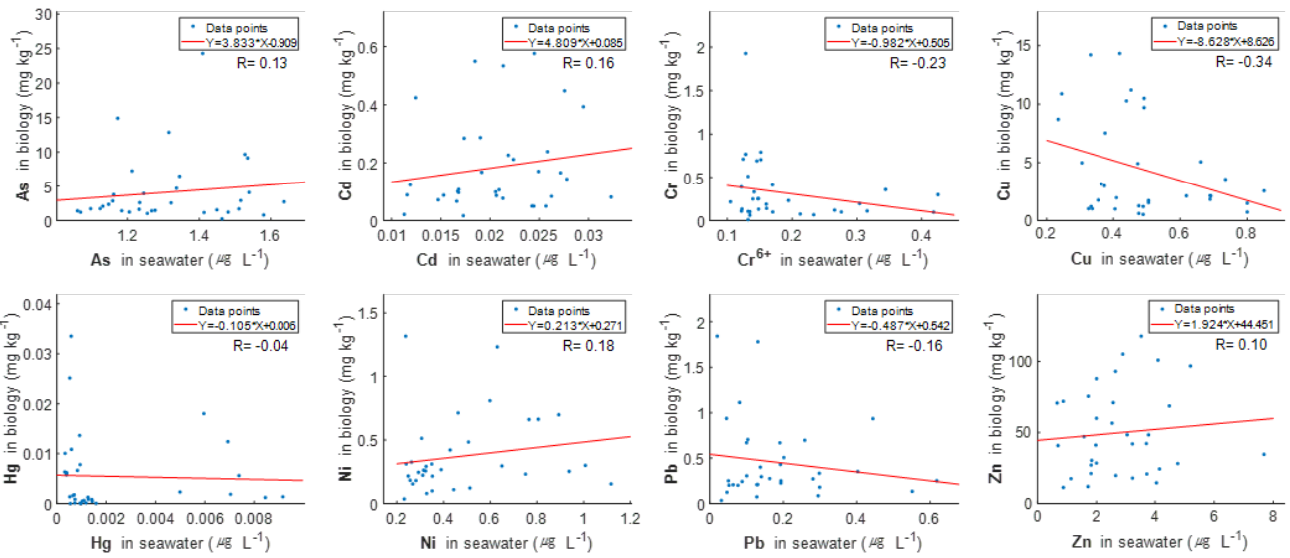
Figure 5. Scatter plots (1:1) and correlation between concentrations of As, Cd, Cr, Cu, Hg, Ni, Pb, and Zn in the seawater and marine organisms.